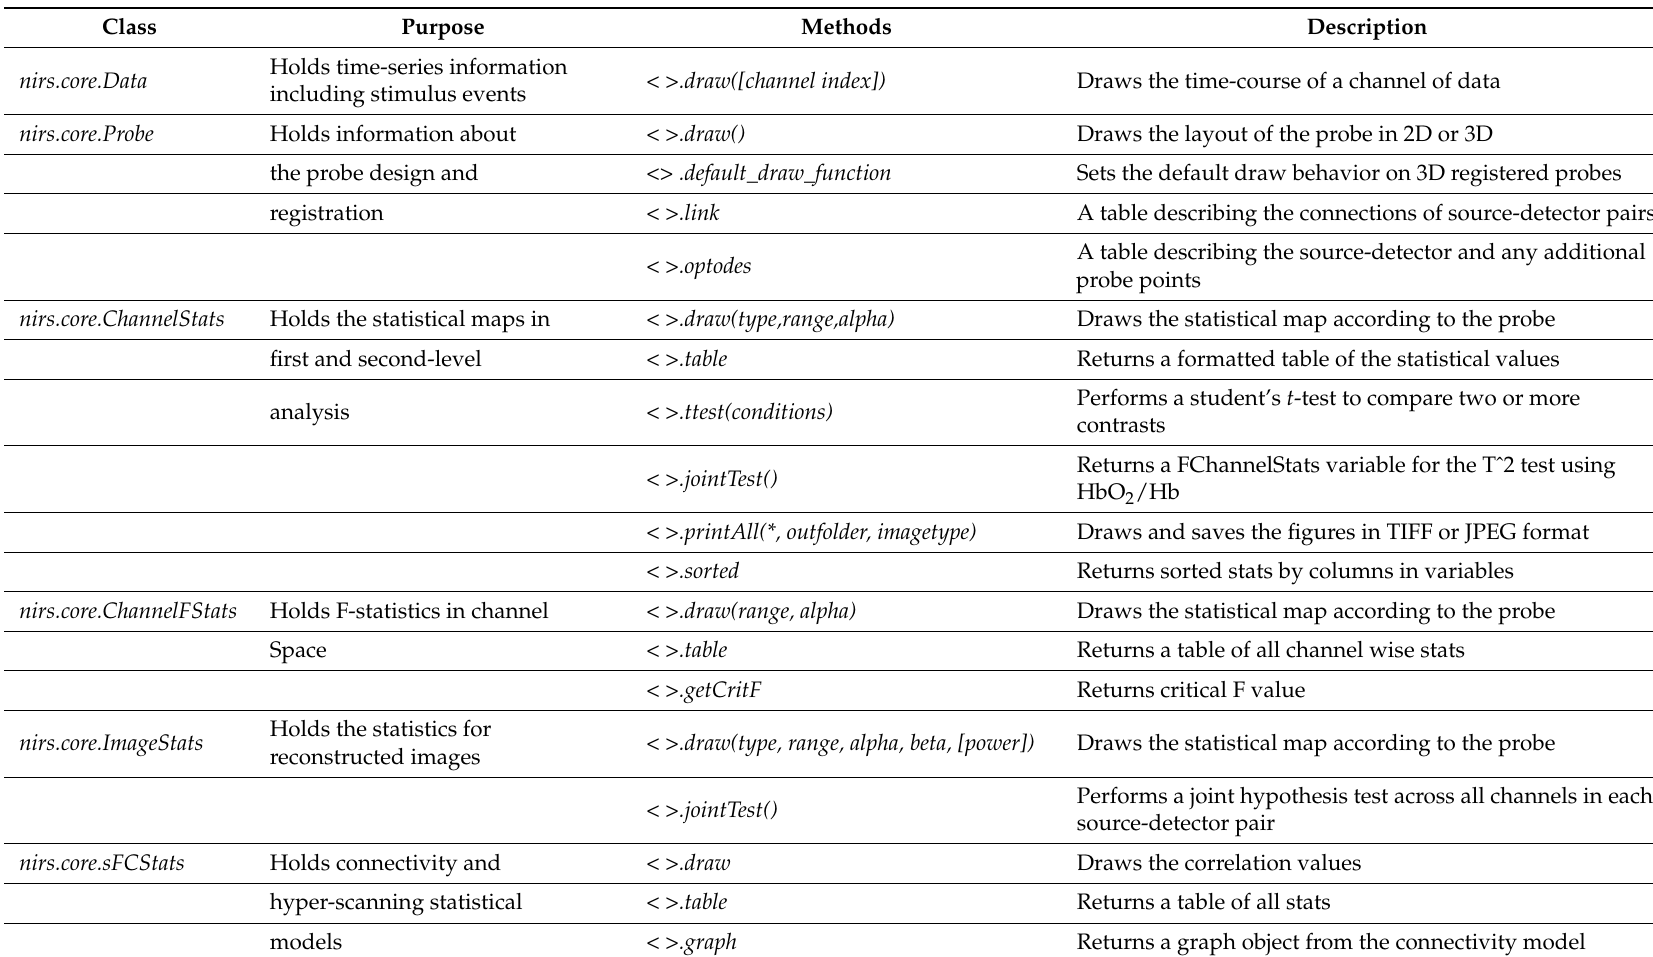
Table 1. List of the core data classes in the AnalyzIR